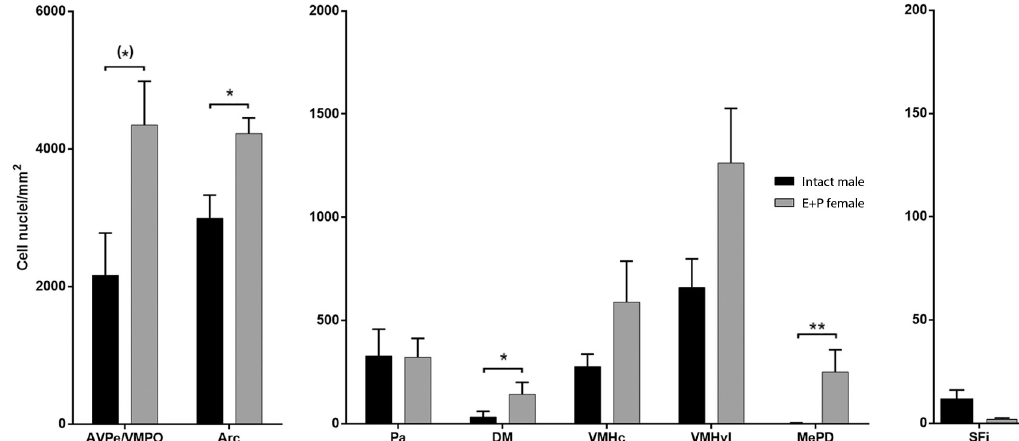
Fig 3. Quantitative analysis of pSTAT5 immunoreactivity in selected brain regions of female and male mice. Assessment of pSTAT5-ir density (pSTAT5-positive cell nuclei/mm 2 ) in the major brain regions with expression of pSTAT5-ir in both male and female mice. Bar histograms show mean interhemispheric pSTAT5-ir density ± SEM in gonadally-intact, vehicle-treated males (Male+PRL; n = 6; black) and ovariectomized females treated with estradiol and progesterone (Female+PRL; n = 6; grey). Counting frames for each of the analyzed nuclei are included in Fig 1. Statistical analysis was applied independently to each brain region (independent t-test for parametric data or Mann-Whitney test for non-parametric data, see Results). � P � 0.05; �� P � 0.01; ( � ) P � 0.06.